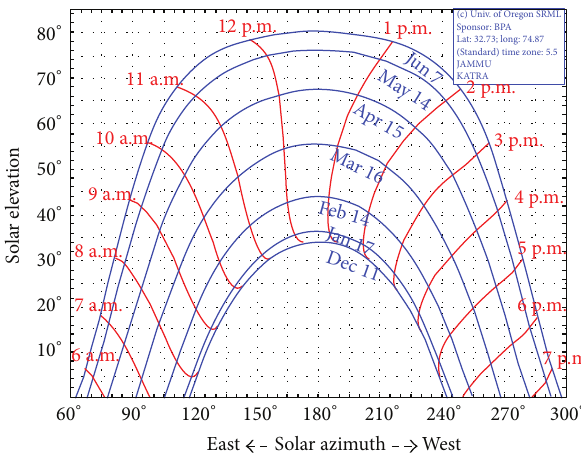
Figure 3: Solar spectral irradiance.